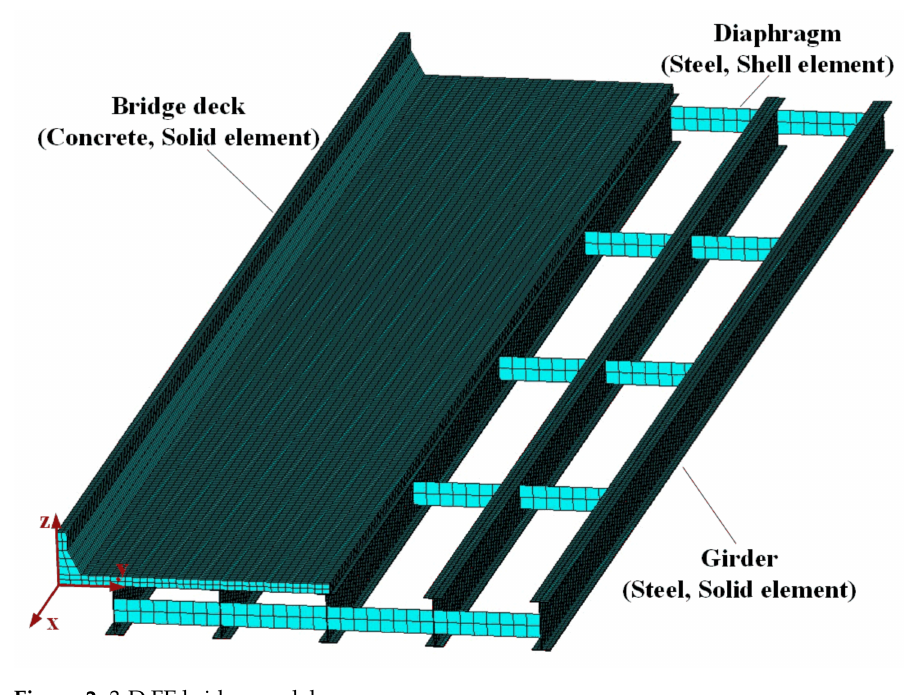
Figure 2. 3-D FE bridge model.